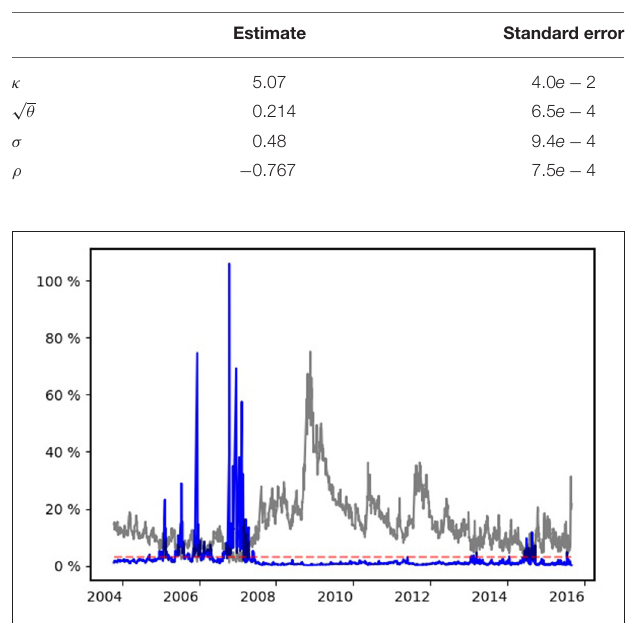
FIGURE 9 | The relative error of the volatility estimate (blue line) and volatility itself (transparent black line). If volatility drops below 3% (dashed, transparent red line), option data yield little information about